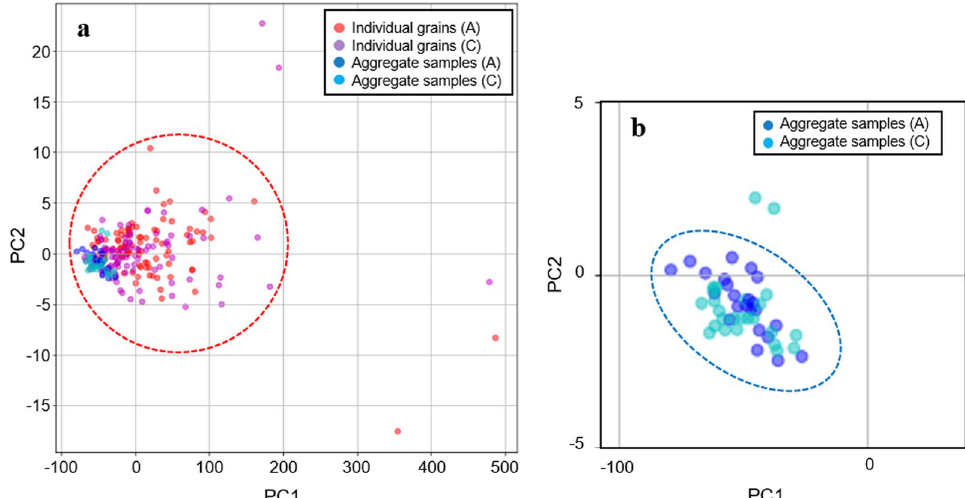
Fig. 5 PCA plot for a all the reflectance spectra including individual grains and aggregate samples, and for b spectra for aggregate samples. Spectra inside the dashed line are included as the homogeneous group. No difference is observed between the samples from chambers A and C